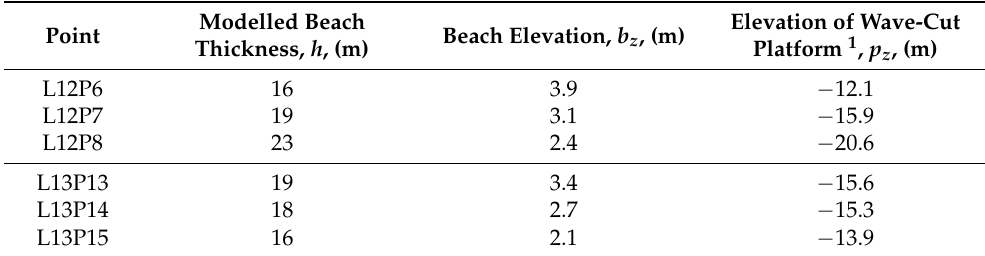
Table 3. Estimated elevation of wave-cut platform from beach elevation and modelled beach thickness at the six nearest points to the beach MASW survey.